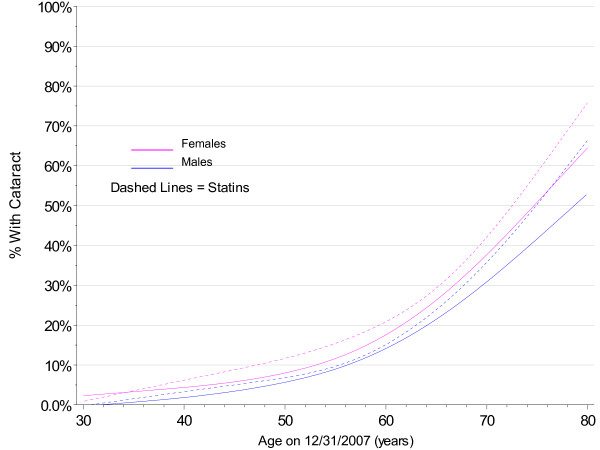
Smoothed 2007 Prevalence of Cataract by Gender and Statin Use Cohort with No Diabetes.